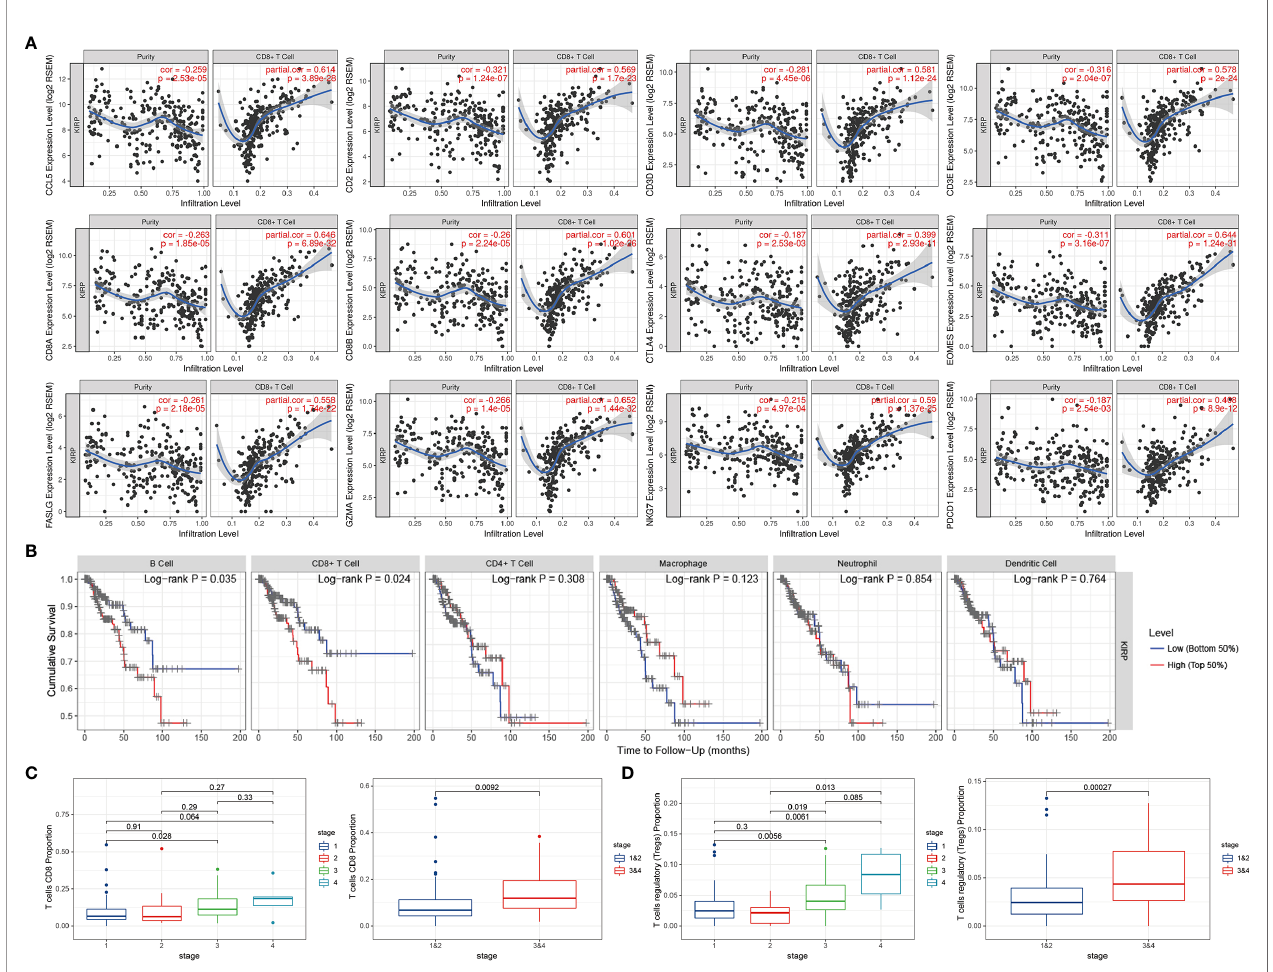
FIGURE 4 | The expressions of hub genes were positively correlated with the in fi ltration level of CD8+ T cells. (A) The expression of 12 hub genes showed a negative correlation with tumor purity, and a positive correlation with the in fi ltration level of CD8+ T cells. (B) Relationship between immune cell in fi ltration and overall survival in KIRP patients. (C) As the tumor progresses, the proportion of CD8+ T cells continues to rise. (D) The proportion of Treg cells continues to rise as the tumor